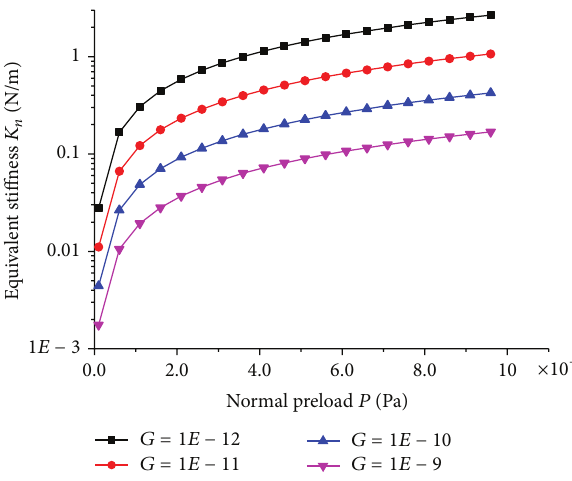
Figure 3: Equivalent normal stiffness of 2Cr13 joint surfaces.